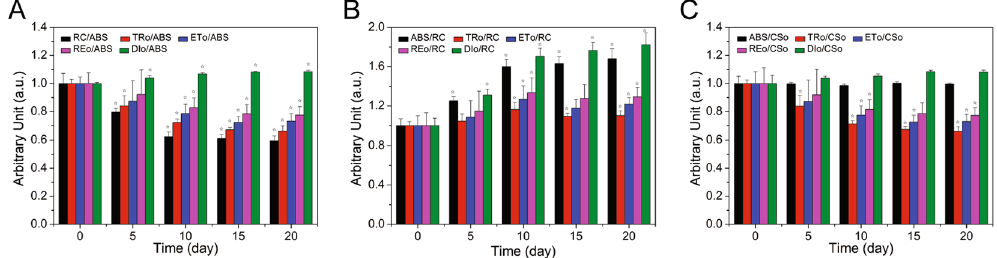
Figure 6. Photosynthetic parameters of nitrogen-starved fluorescence transients analyzed by the JIP test relative to those of cells at day 0. ( A ) energy flux ratios representing the following structural parameters: RC/ ABS, density of PSII RC per absorption; TRo/ABS, maximum quantum yield for primary photochemistry; ETo/ ABS, quantum yield for electron transport between the two photosystems; REo/ABS, the quantum yield for reducing terminal electron acceptors at PSI; and DIo/ABS, the quantum yield of energy dissipation. ( B ) specific energy fluxes (per active RC) representing the following functional parameters: ABS/RC, absorption flux; TRo/RC, trapping flux; ETo/RC, electron transport flux; REo/RC, electron flux for reducing terminal electron acceptors at the PSI side; and DIo/RC, dissipated energy flux. ( C ) the phenomenological energy fluxes (per excited cross-section (CS)), which are described as follows: ABS/CSo, absorption flux; TRo/CSo, trapped energy flux; ETo/CSo, electron transport flux; REo/CSo, electron flux for reducing terminal electron acceptors at the PSI side; and DIo/CSo, dissipated energy flux. ( ☆ = P < 0.05 vs. control)